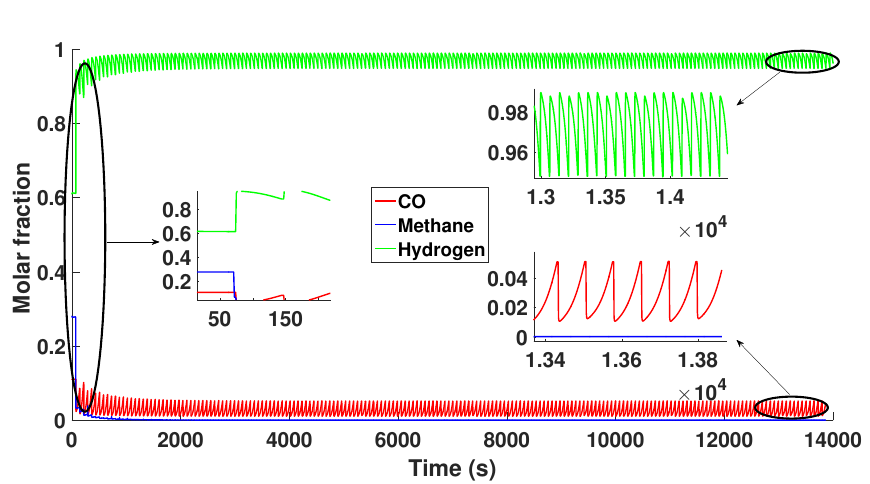
Figure 3. Separation and production of bio-hydrogen from start-up until reaching the CSS. The pressure swing values for each step are shown in Figure 5 and the start times for each step are shown in Figure